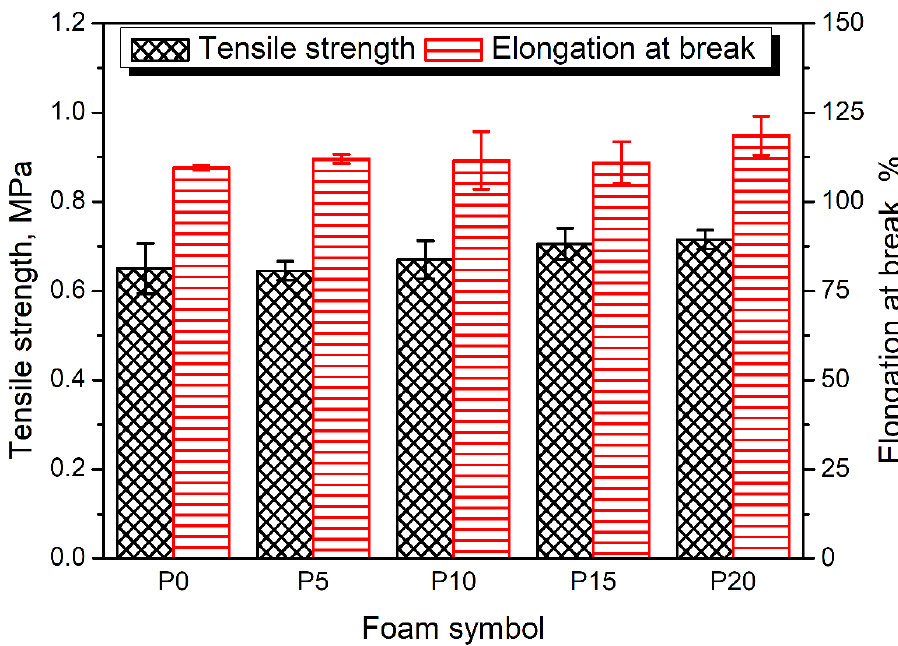
Figure 7. Results of static tensile tests performed for prepared samples.